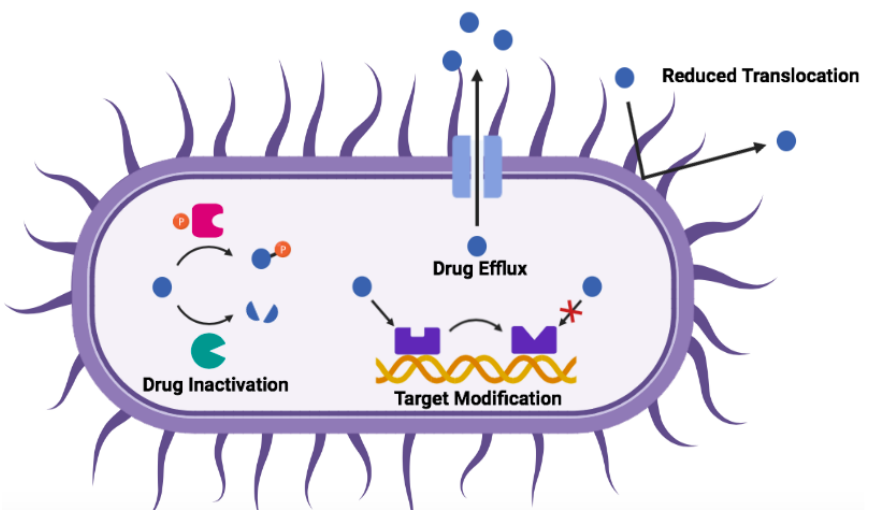
Figure 2. Mechanisms of acquired antibiotic resistance by bacteria. Drug represented as a dark blue sphere.